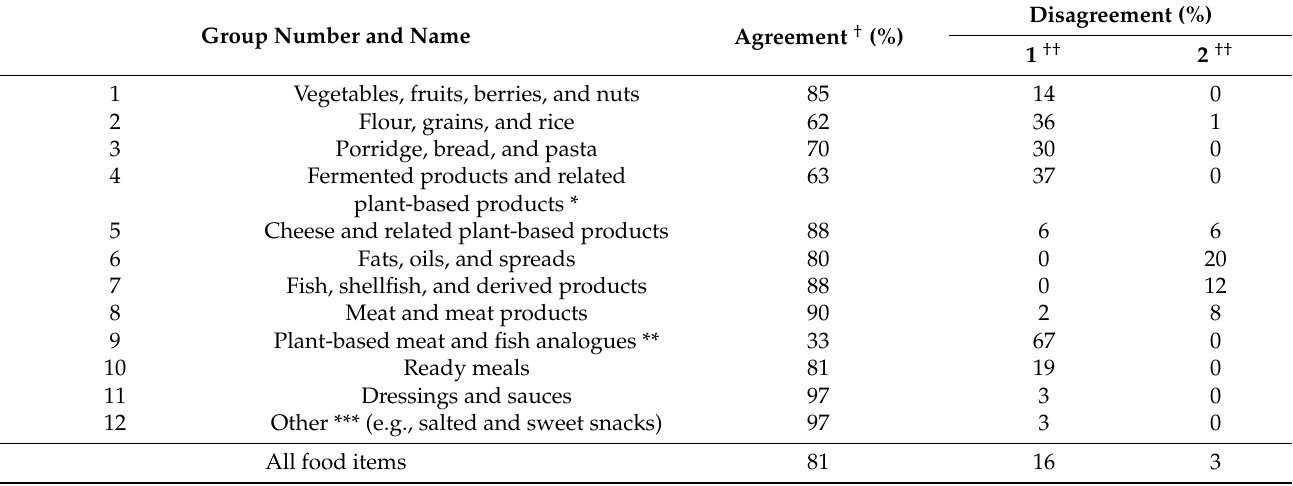
Table 4. The percent (%) of agreement and disagreement for included food items, separated by group according to the current Keyhole criteria (LIVSFS